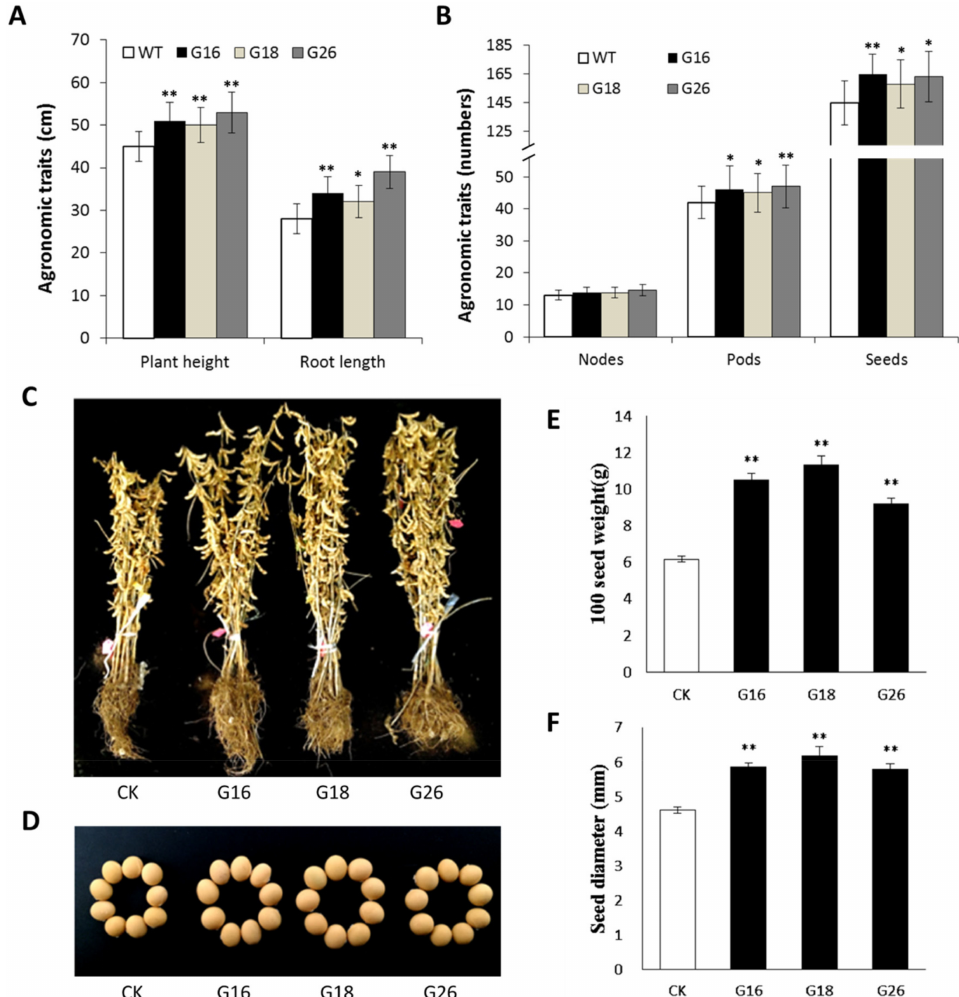
Figure 7. Investigation of plant and agronomic traits of transgenic lines. *: p -value ≤ 0.05; **: p -value ≤ 0.01; ( A ) Plant height and root length of G16, G18, G26 and CK; ( B ) The number of branches, nodes, pods and seeds in the transgenic lines and non-transgenic plants; ( C ) The phenotype of GmNFYB17 after harvest; ( D ) Comparison of seed size among GmNFYB17 lines and CK; ( E ) The 100-seed weight of the transgenic lines and non-transgenic plants; ( F ) The diameter of transgenic and non-transgenic